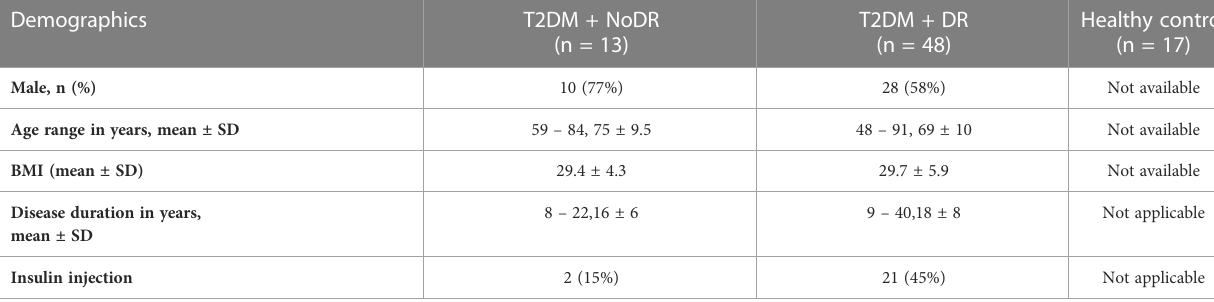
TABLE 1 Demographic data from the participants included in the